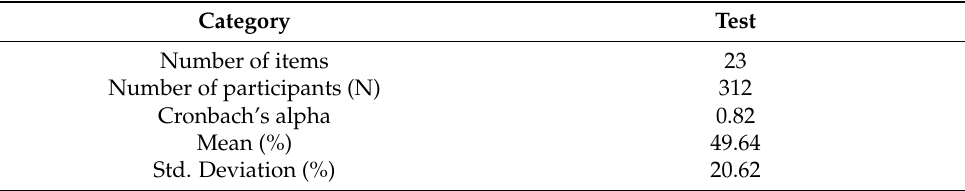
Table 5. Digital test of visual communication: “produce” domain.